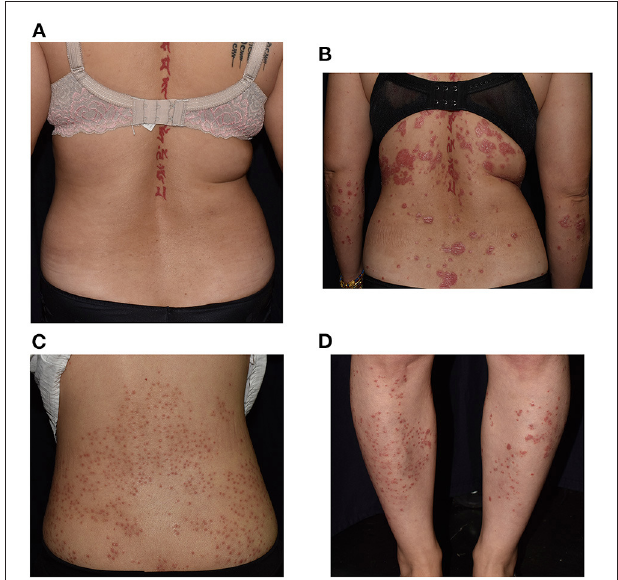
FIGURE 2 | Severe exacerbation with morphological change in a 40-year-old woman with a history of psoriasis for more than a decade, worsening from Psoriasis Area Severity Index (PASI) 2.8 (A) to 10.7 (B) . Photos of the back (C) and lower legs (D) of a 39-year-old woman with chronic plaque-type